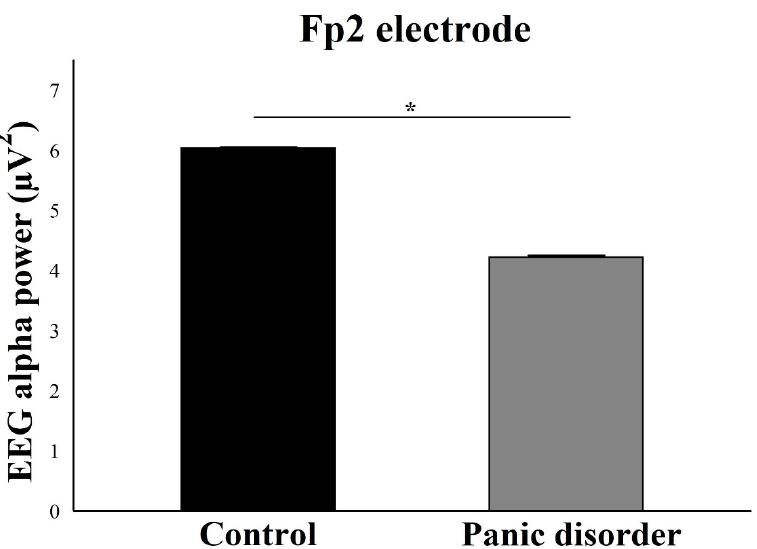
Figure 7. Main effect for group ( p = 0.002). The EEG alpha power for Fp2 electrode decreases in the experimental group compared to the control group. The result is represented by the mean ± standard error and the statistically significant difference is indicated with *, p < 0.05.